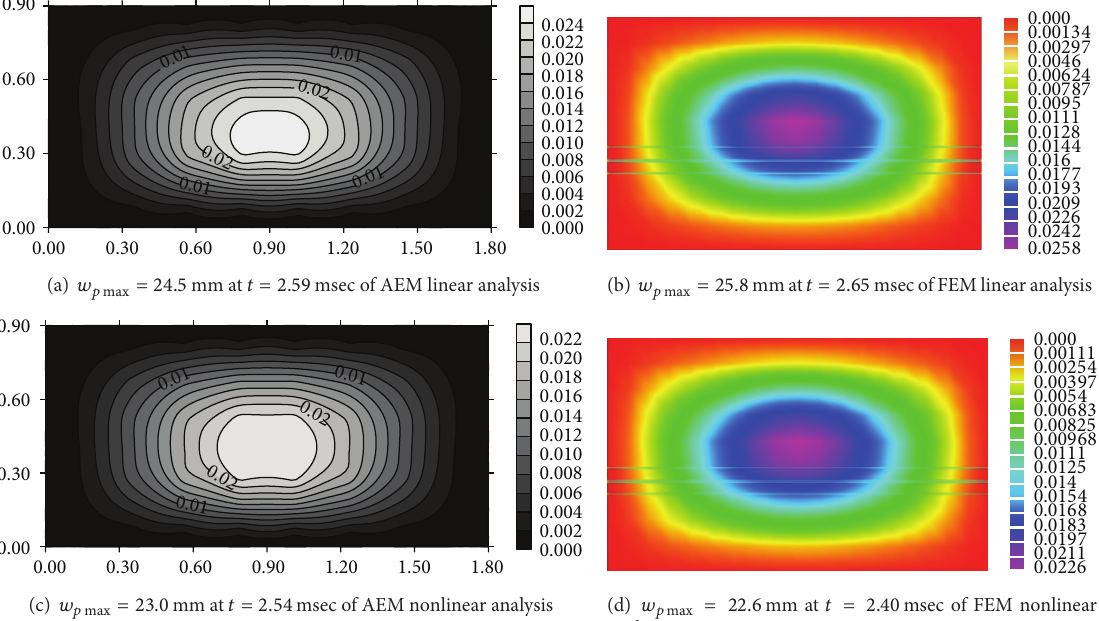
Figure 15: Contour lines of deflection 𝑤 𝑝 of the stiffened plate of Example 3, employing the present study (a, c) and a FEM [25] solution using solid elements (b, d) at the time of maximum transverse